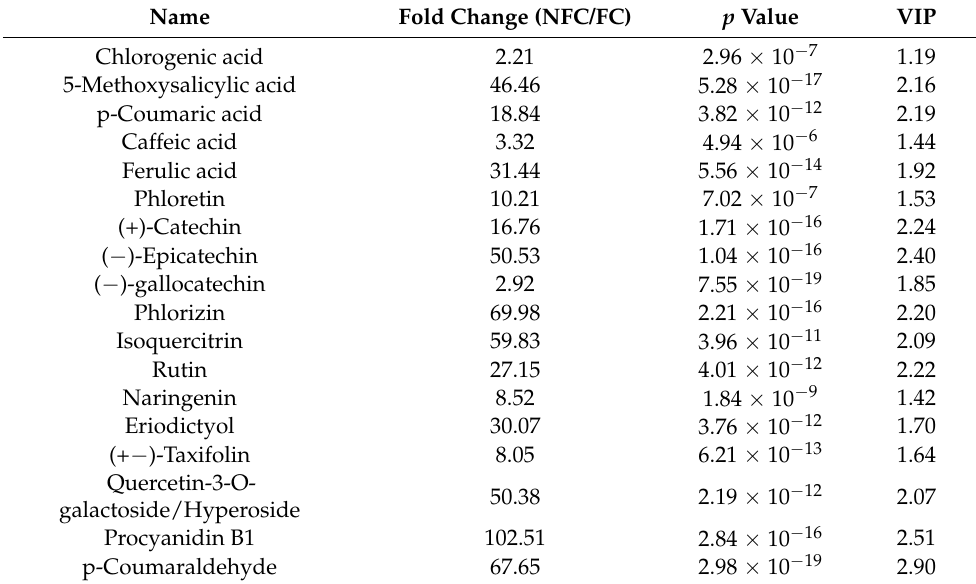
Table 3. Polyphenol compounds of NFC and